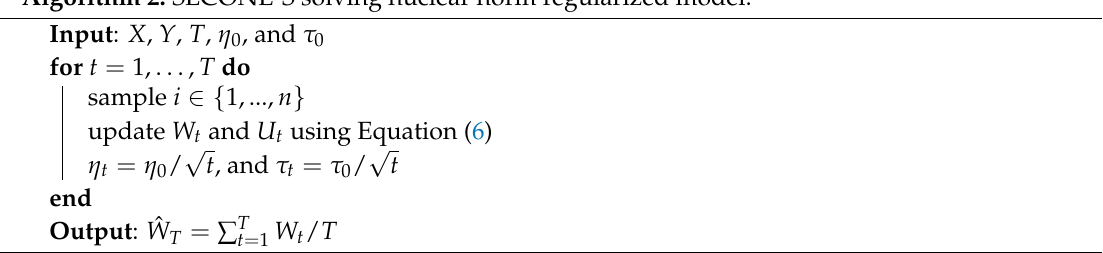
Algorithm 2: SECONE-S solving nuclear norm regularized